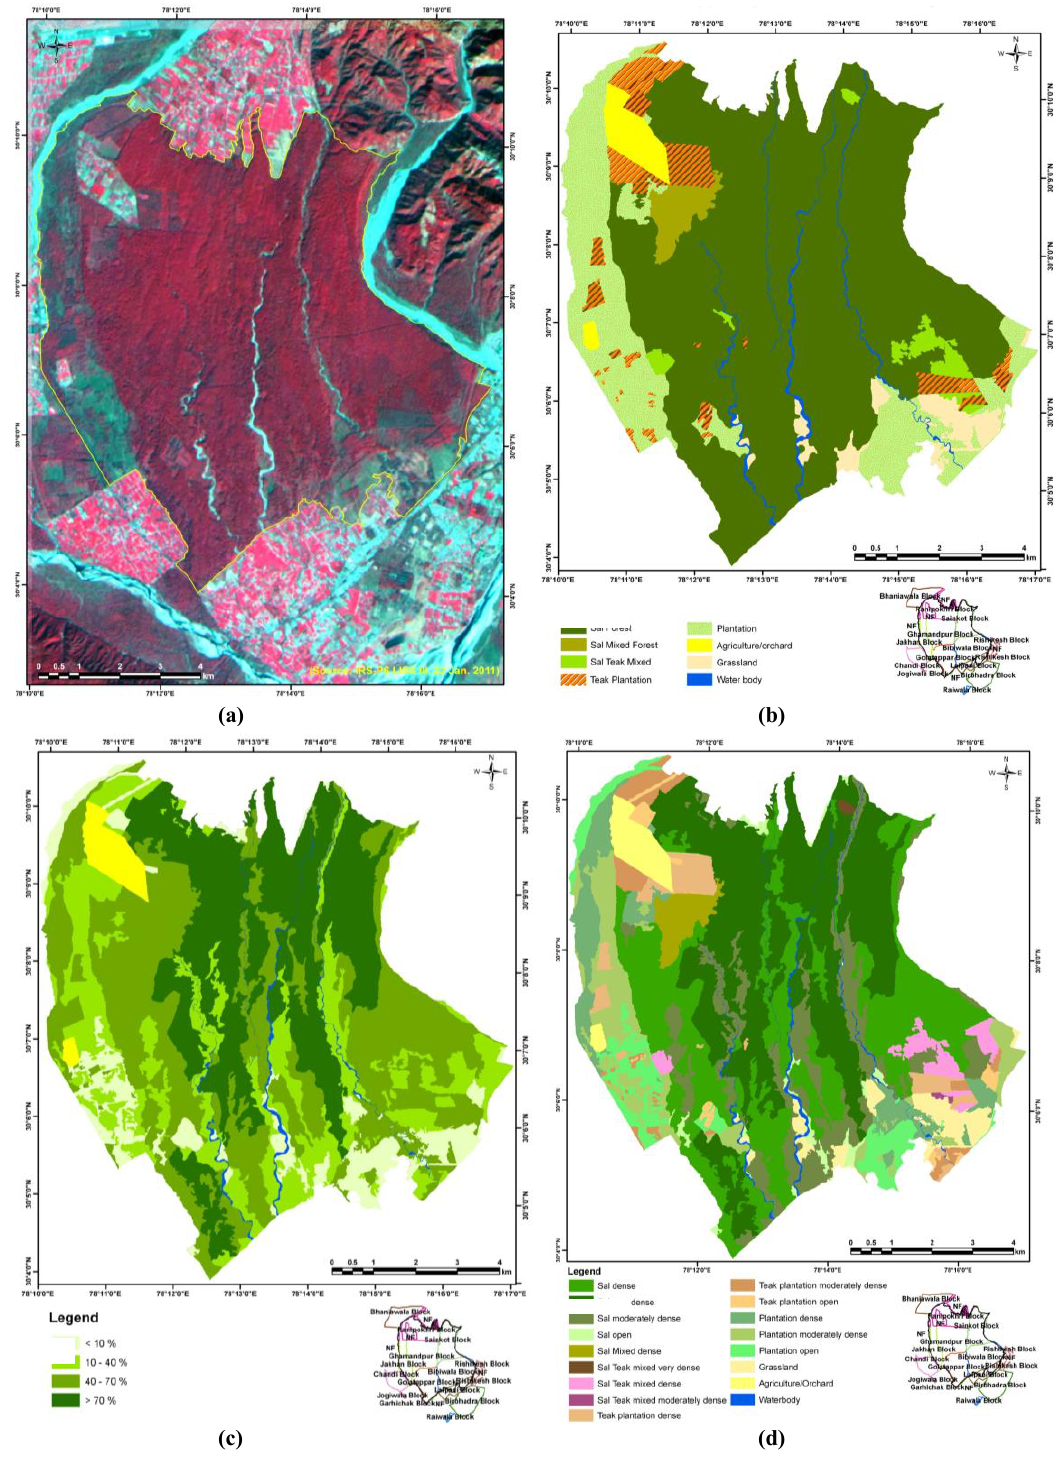
Fig. 3 (a). FCC of study area, (b). Forest/land use map, (c). Crown density map and, (d). Forest type-density strata